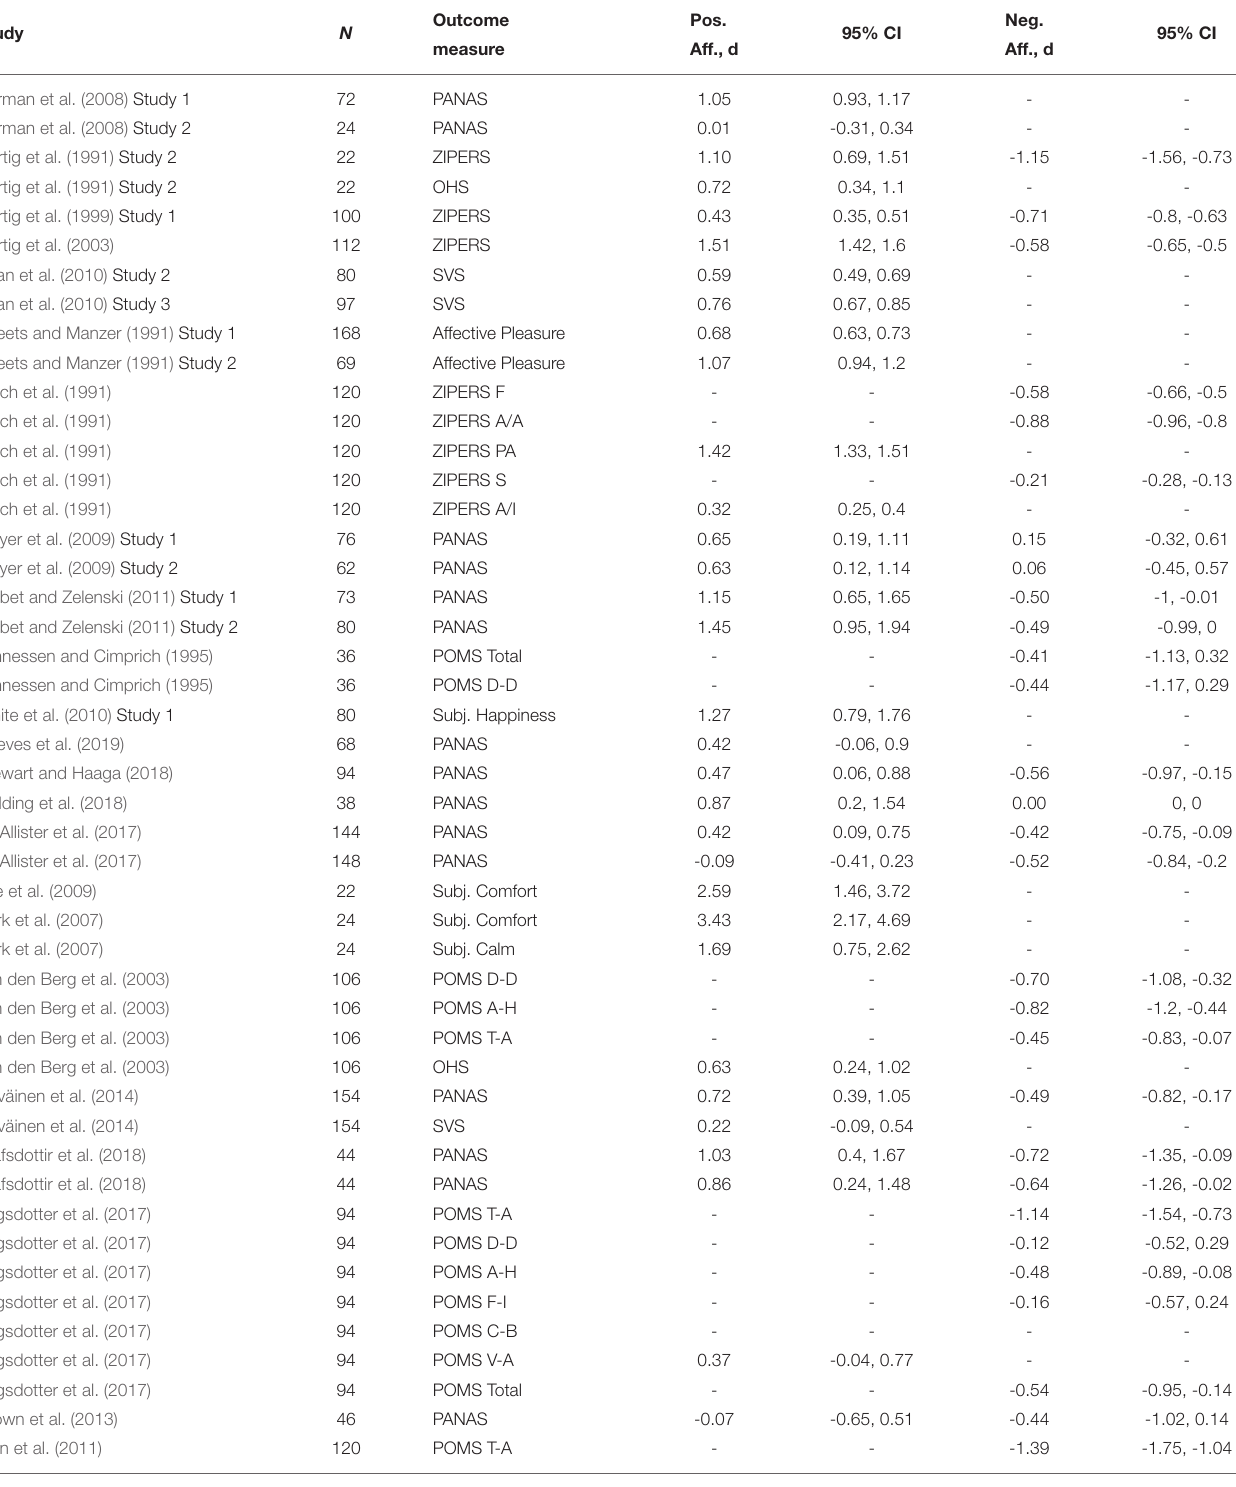
TABLE 2 | Summary of effect size data from experimental studies reporting on the relative effect of exposure to natural and urban environments on positive and negative affect.